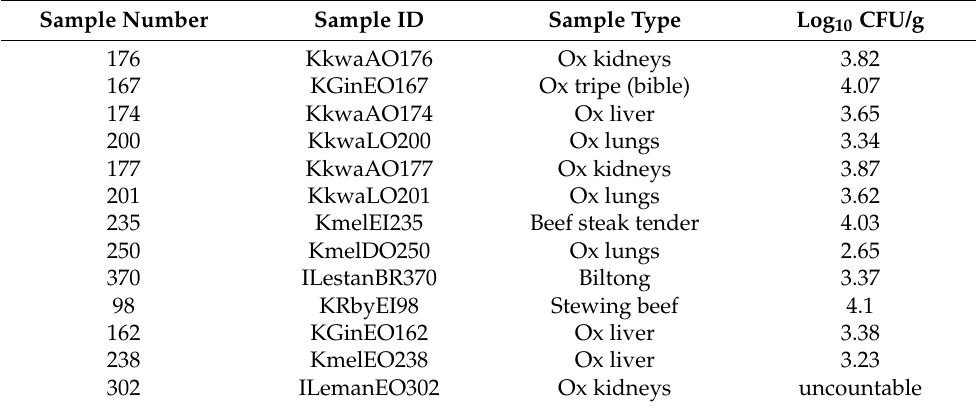
Table 3. S. aureus counts from beef and beef products.